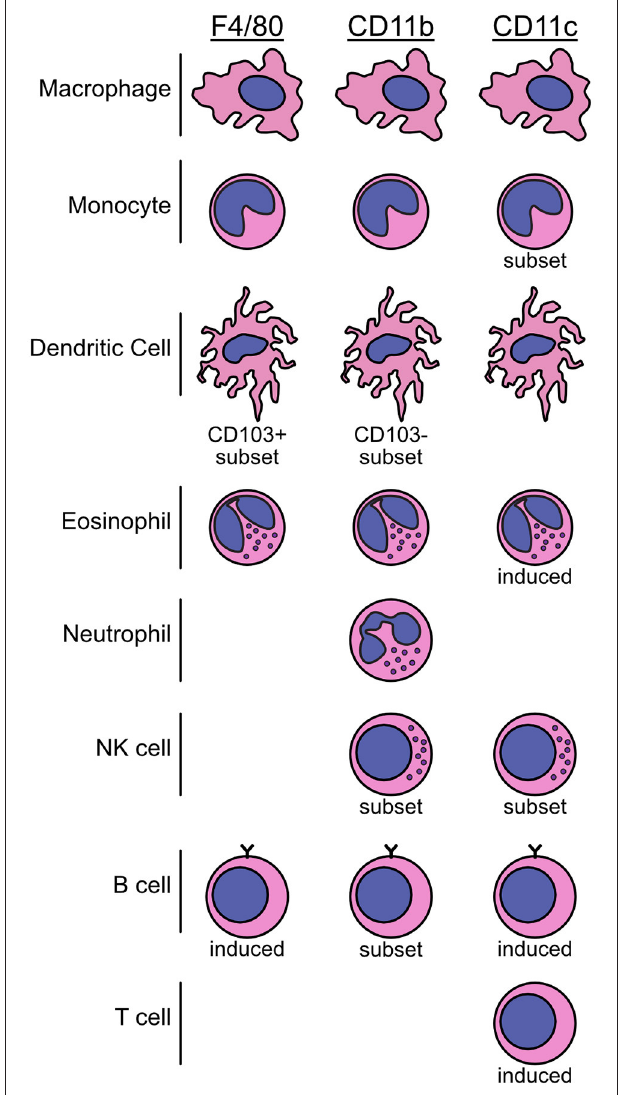
FIGURE 2 | Summary schematic of immune cell populations in mice that express the F4/80, CD11b, and CD11c markers. The use of F4/80, CD11b, and CD11c markers to specifically detect or deplete macrophages has led to a lack of clarity in the AKI field. These molecules are not restricted to macrophages, monocytes, or DC and can be expressed by a variety of immune cell populations and subsets. Further, they can be expressed basally or be induced on specific cell types. Over-reliance on these three molecules without additional characterization can lead to uncertainty about which cells are responsible for an experimental outcome, hindering the ability to draw precise conclusions. The overlapping, diverse expression patterns of these markers is illustrated schematically